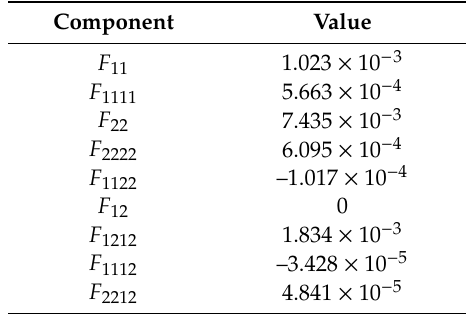
Table 4. Resulting tensorial components for FFF failure surface